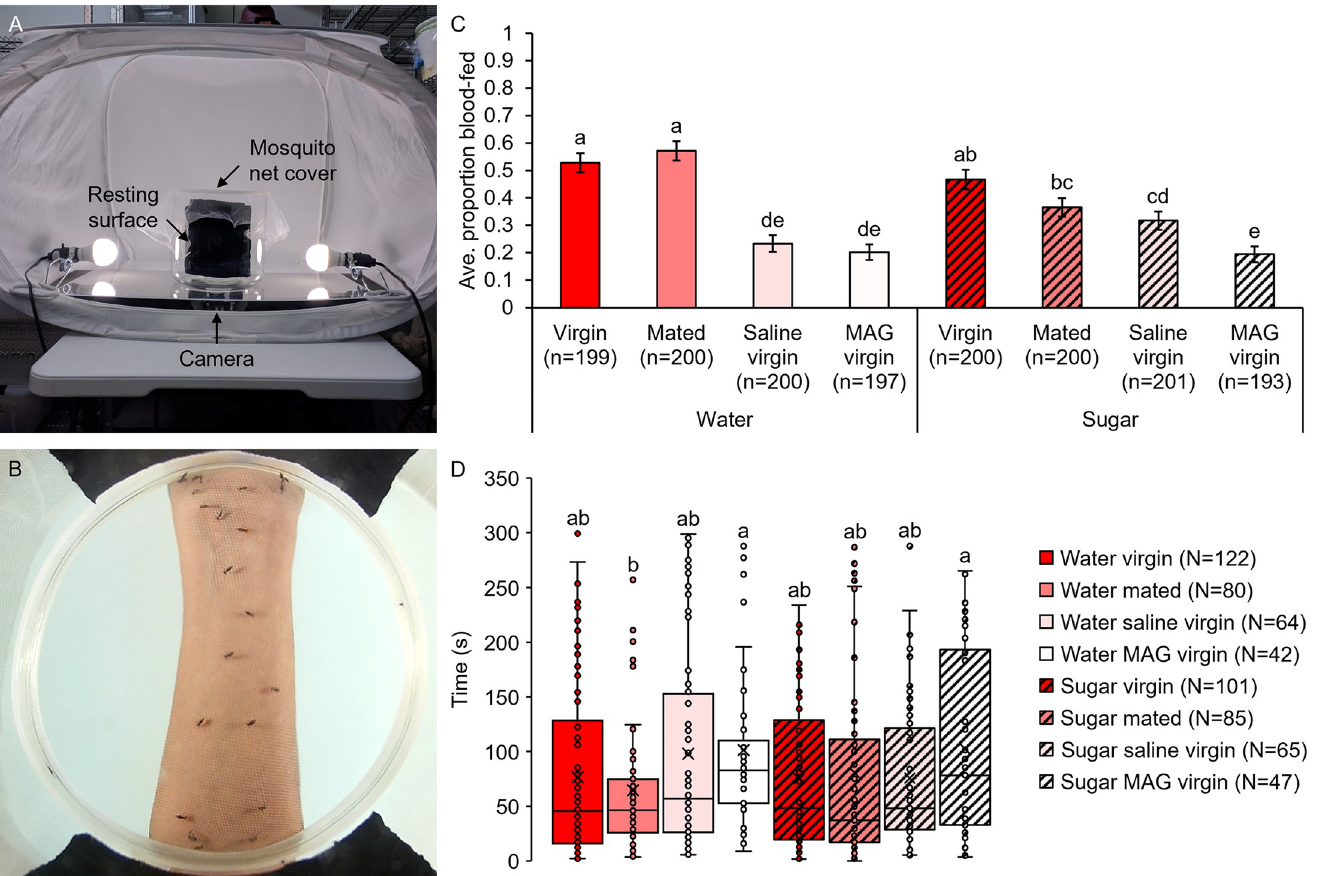
Fig 3. Mating and MAG do not affect blood-feeding avidity or latency to feeding on a human host arm, but sugar feeding lowers avidity. Blood-feeding avidity experiment setup (A) with an accompanying still image from a feeding latency video showing mosquitoes feeding on a host forearm (B). (C) Blood-feeding avidity was similar between non-injected virgin and mated females as well as between saline- and MAG-injected females. Injection and sugar feeding both lowered blood-feeding avidity. (D) Latency to blood feeding did not differ between treatment groups. Error bars in panel C denote SE of sample proportions and whiskers in panel D denote the minimum and maximum values. Box plots display the boundaries of the first (bottom) and third (top) quartiles, median lines, mean markers (“x”), and individual data points, including outliers. Letters above columns and box and whisker plots denote H-B-corrected post-hoc comparison